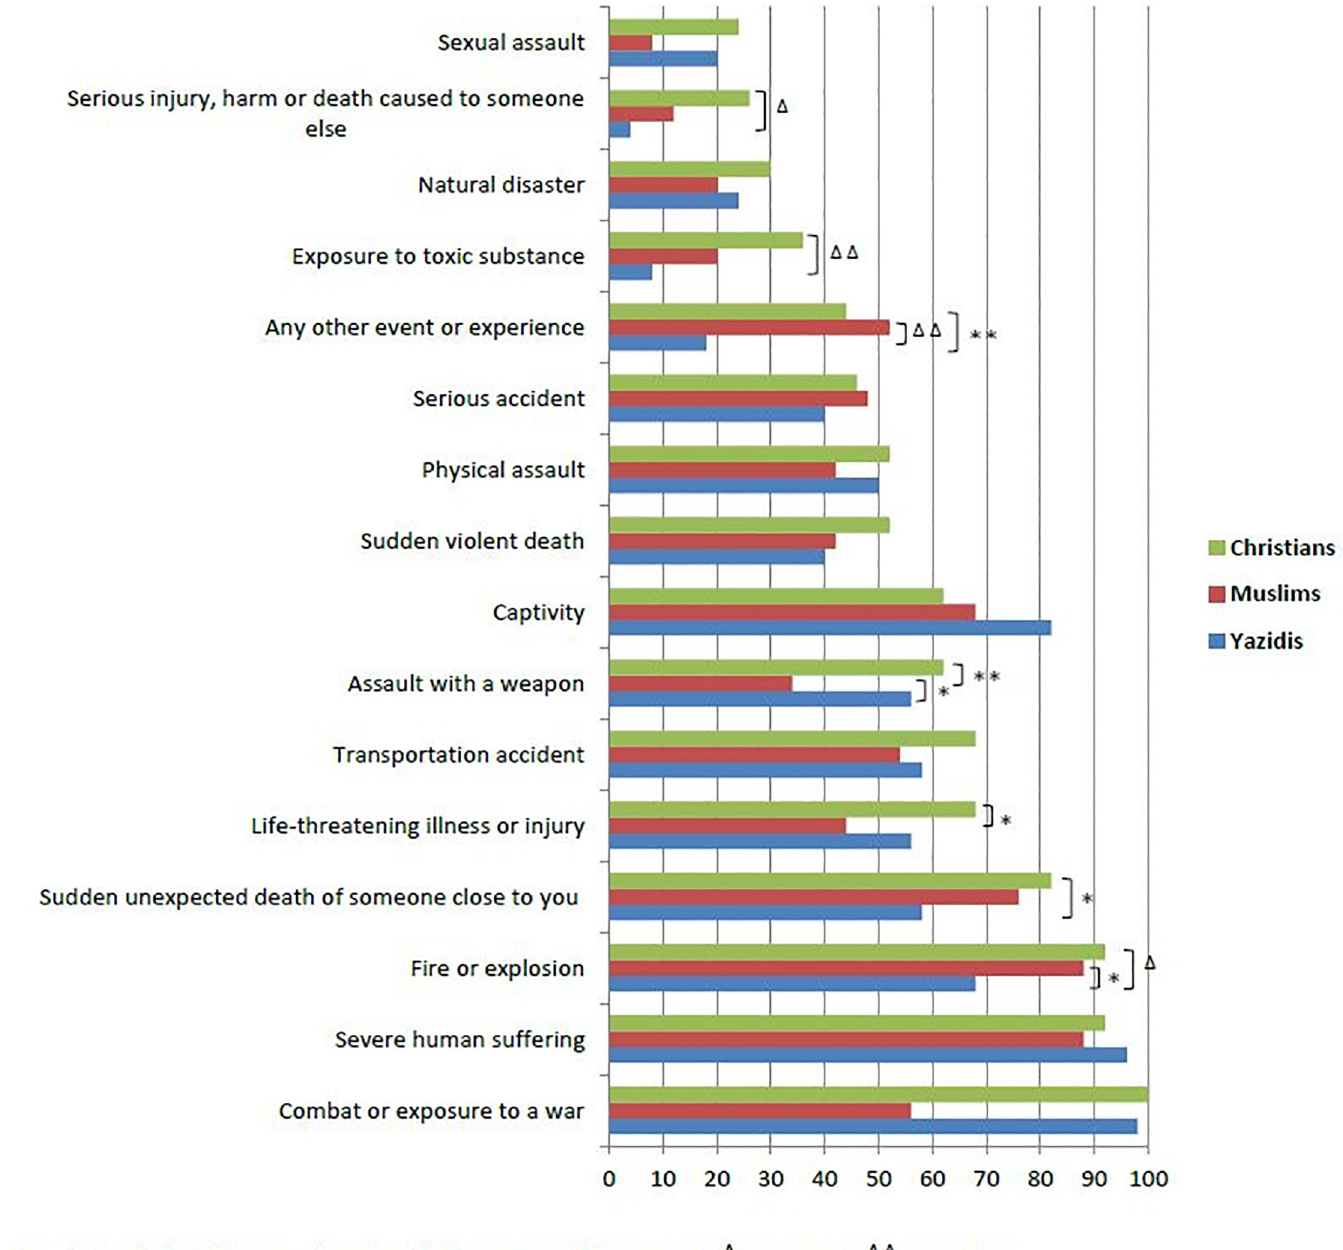
Fig 1. Lifetime trauma exposure according to religious